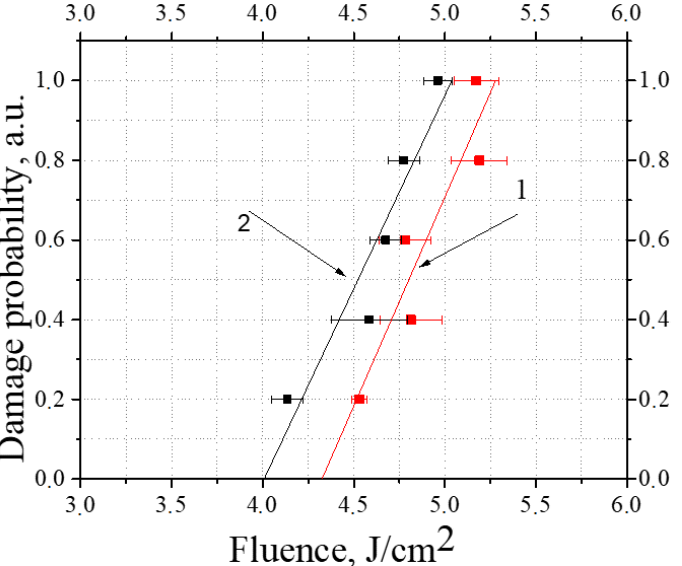
Figure 6. Damage probability vs fluence for ZnSe_Ar for PRR 12 kHz (1) or 16 kHz (2). The exposure duration was 1 s. Table 1. The PRR of the laser radiation, f ; the number of the damaged sites, N ; the average quadratic error, < ∆ W 2 av >; the K coefficient of the error dispersion at the confidence probability of F = 0.95; the average laser-induced damage threshold (LIDT) fluence, W av ; the 0-probability LIDT fluence, W 0d , for the ZnSe samples with different annealing atmospheres. The exposure duration was 1